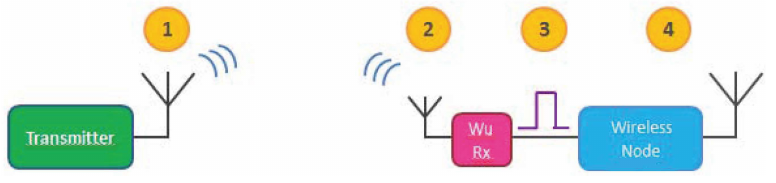
Figure 1. Wake-up communication system operation.